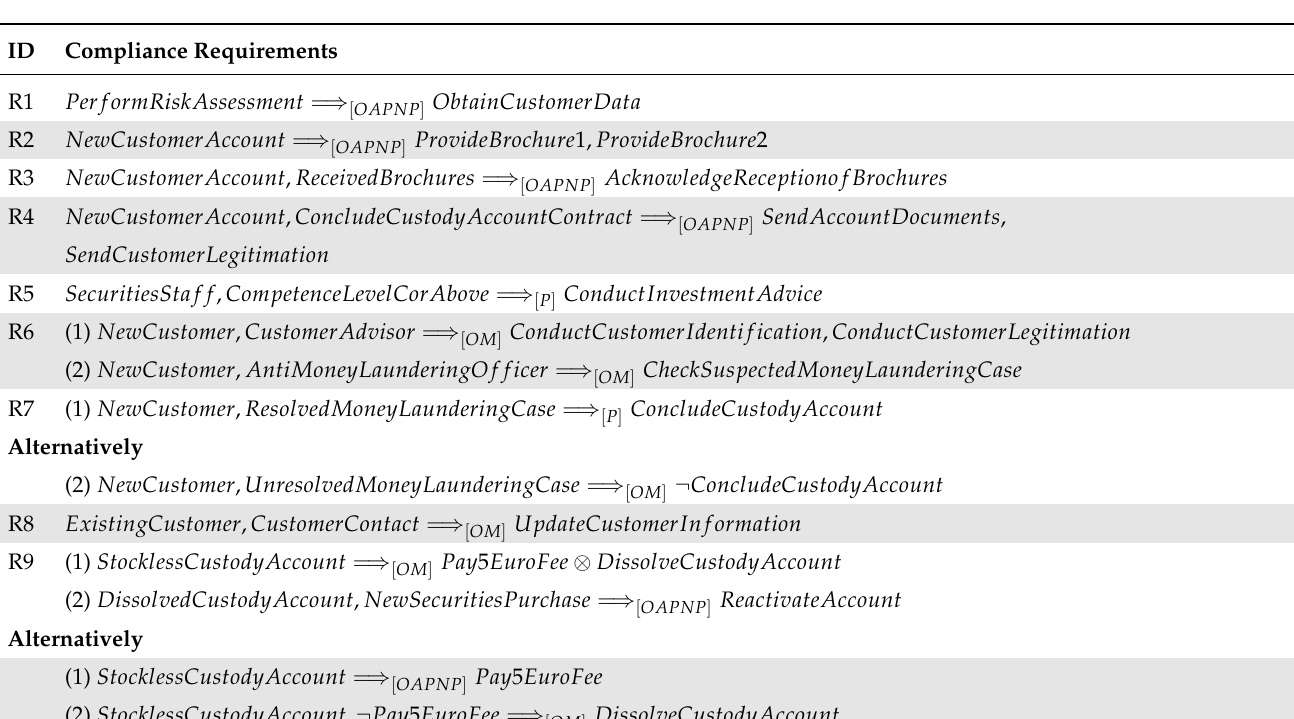
Table 13. Formalised requirements in PCL